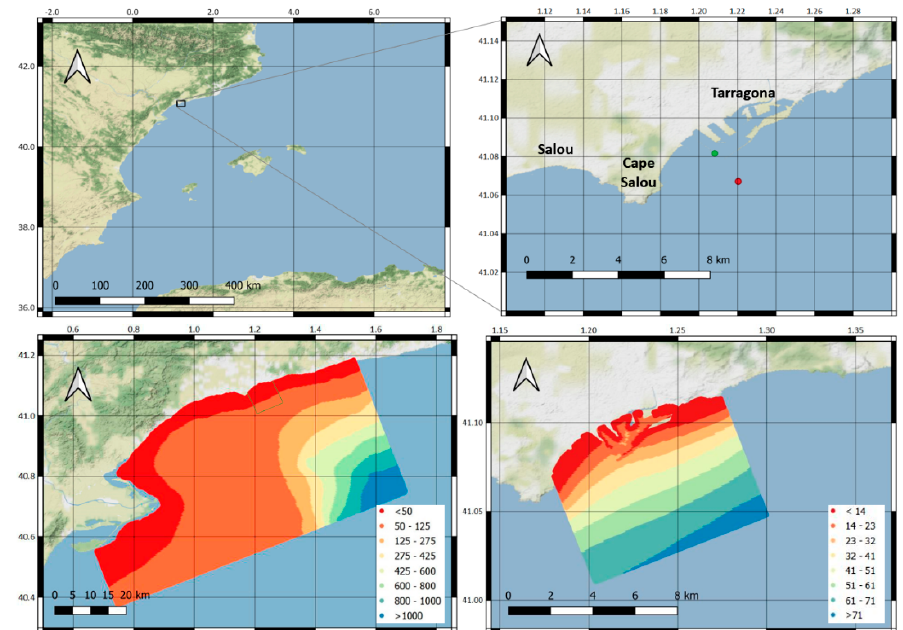
Figure 1. ( up-left ) Study location in the western Mediterranean; ( up-right ) situation of the spill points: dock (green dot) and monobuoy (red dot); ( low-left ) coastal and ( low-right ) port numerical domains of SAMOA data in Tarragona with bathymetry (in meters). Green box in the low-left figure represents the numerical boundary of the port domain nested in the coastal domain.